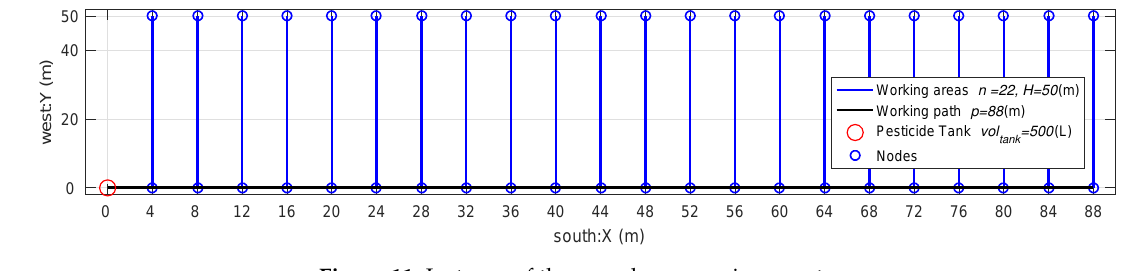
Figure 11. Instance of the greenhouse environment.